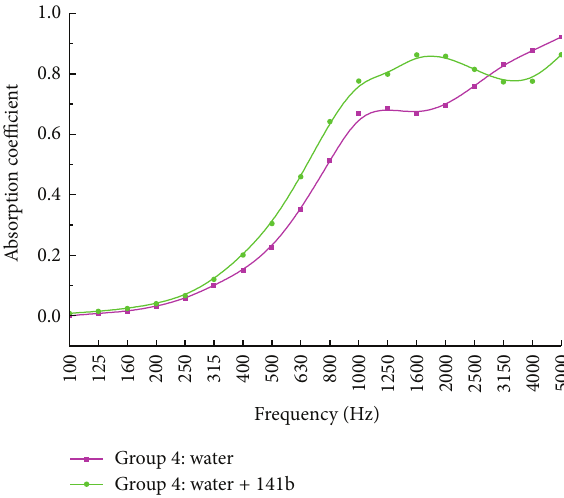
Figure 11: Curves of sound absorption character of the PU foams with two different compositions, one containing water without 141b and the other containing water with